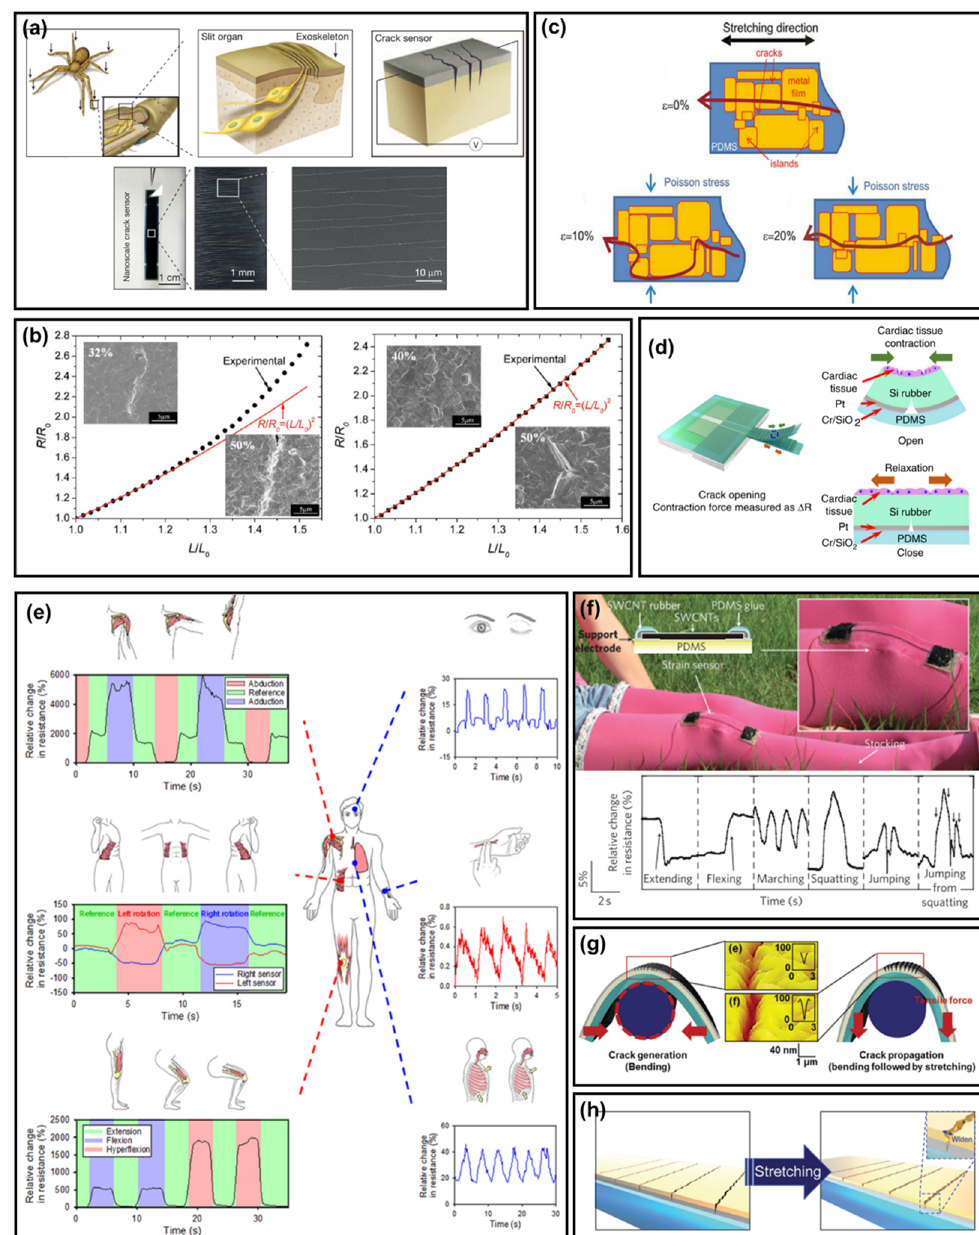
Figure 5. ( a ) Schematic illustrations and images of an ultra–mechanosensitive nanoscale crack junc- tion–based sensor inspired by the spider sensory system [174]. ( b ) Schematic view at 0, 10, and 20% strain of a gold island matrix on PDMS, and corresponding conducting percolation path, after sev- eral thousands of stretching cycles [181]. ( c ) Tensile test results with and without a Cr interlayer [182]. ( d ) Concept of a highly durable crack sensor working in culture media [201]. ( e ) Whole–body motion–monitoring system [16]. ( f ) SWCNT–based stretchable wearable devices and relative changes in resistance versus time for breathing, phonation (speech), knee motion, and data glove con fi gurations, respectively [193]. ( g ) Schematic illustrations of crack–based sensor, its mechanism, its geometrical factors for sensitivity, and crack depth–modulated procedure [200]. ( h ) Illustration of the cracks on the sensor before ( left ) and after stretching ( right ). Cracks on the conductive metal layer are induced by those on the interlayer underneath the metal layer [196].